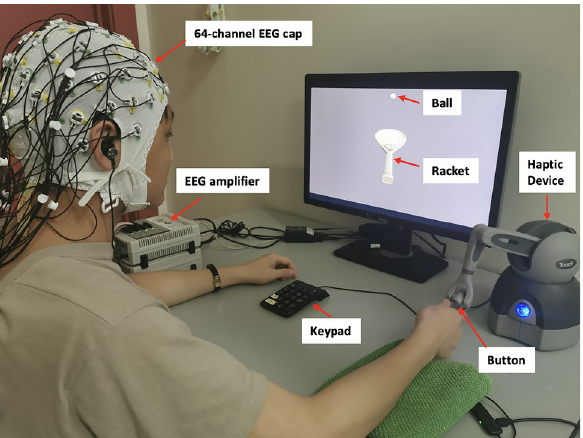
Figure 1. The participant is seated in the experimental room, and the EEG cap is placed on the scalp. Electrodes are connected to the EEG amplifier via a multi-wire planar cable. The participant holds the stylus of the haptic device with their right hand placing their thumb on the button integrated into the stylus (for the passive task). The game is displayed on a computer screen one meter away from the participant. A keypad is placed next to the participant’s left hand to answer if there was a delay or not in the previous trial whenever asked. A folded towel is placed underneath the participant’s arm for better comfortability. The participant is trained on using the haptic device with minimal body movement to avoid excessive EEG artifacts. The participant is asked to stay seated and use one hand to move the wrist up and down (during the active task) while the elbow is rested without movement.